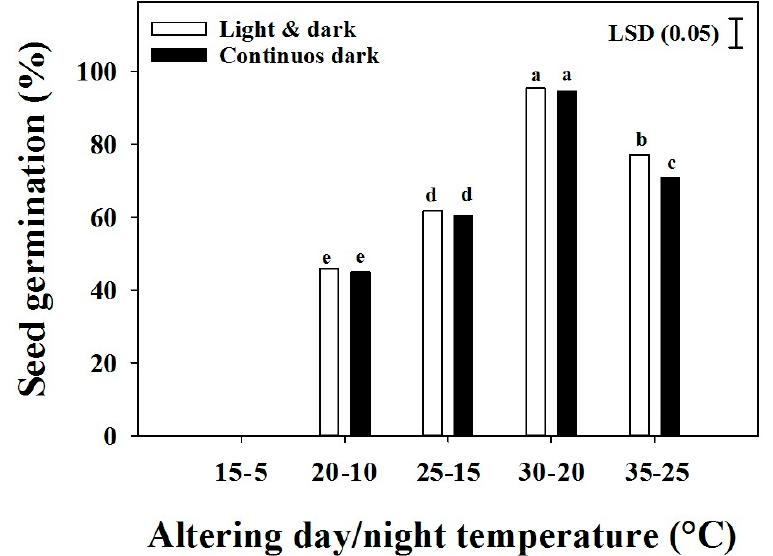
Figure 3. The effect of alternating the day/night temperature and light on the seed germination of three biotypes of Brachiaria eruciformis . Each bar of the graph represents a mean value of the germination data (pooled across biotypes), as no significant di ff erences were observed among biotypes. The vertical bar shows the least significant di ff erence (LSD) values at the 5% level of